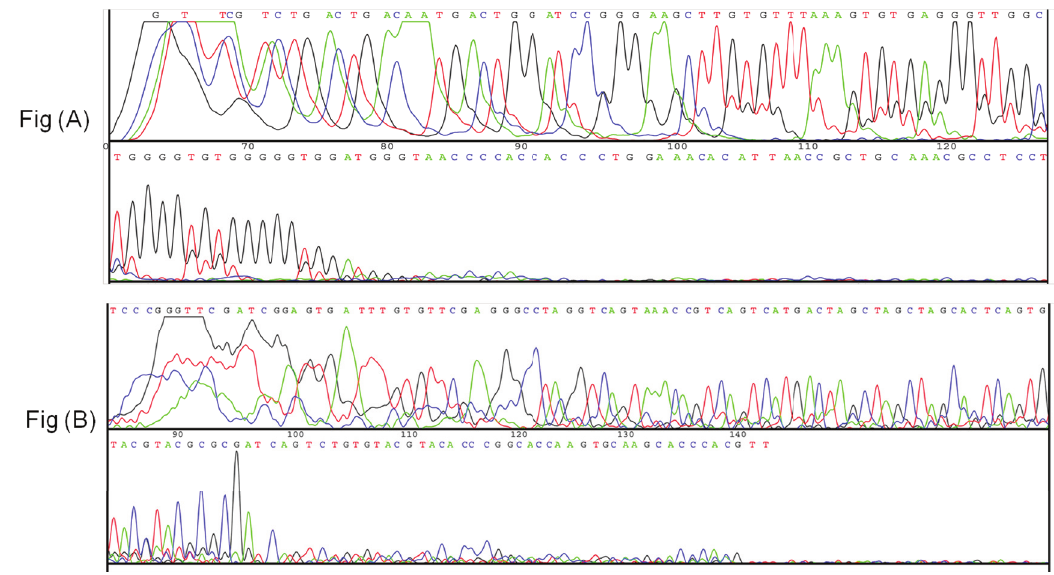
Figure 5. DNA sequencing results. Sequencing results in ( A ) show that 120 bp DNA was amplified as it is while sequencing results in ( B ) confirm that PCR products were obtained as per the scheme shown in Figure 2.